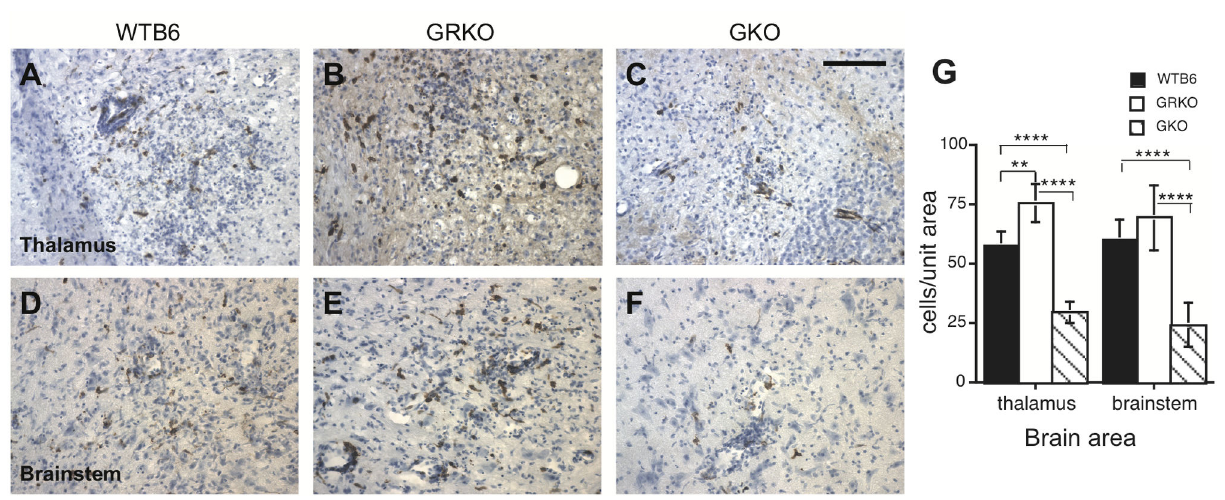
Figure 7. Immunohistochemical staining for MHC class II. Frozen sections from the thalamus (A-C, upper panels) and brainstem (D-F, lower panels) of WTB6 (A,D), GRKO (B,E) and GKO (C,F) mice were stained with mouse monoclonal anti-I-A/I-E for identification of MHC class II antigen-positive cells 7 days after intranasal infection with 10 5 pfu NSV. X250. Scale bar = 100 um. (G) Quantification of MHC class II-positive cells/0.16 mm 2 tissue in thalamus and brainstem from 2 animals in each group. Photomicrographs of 5-6 areas of thalamus and 10 areas of brainstem were taken and stained cells counted. Each bar indicates the mean and SEM. ** P < 0.01, *** P < 0.001, **** P < 0.0001; t test.